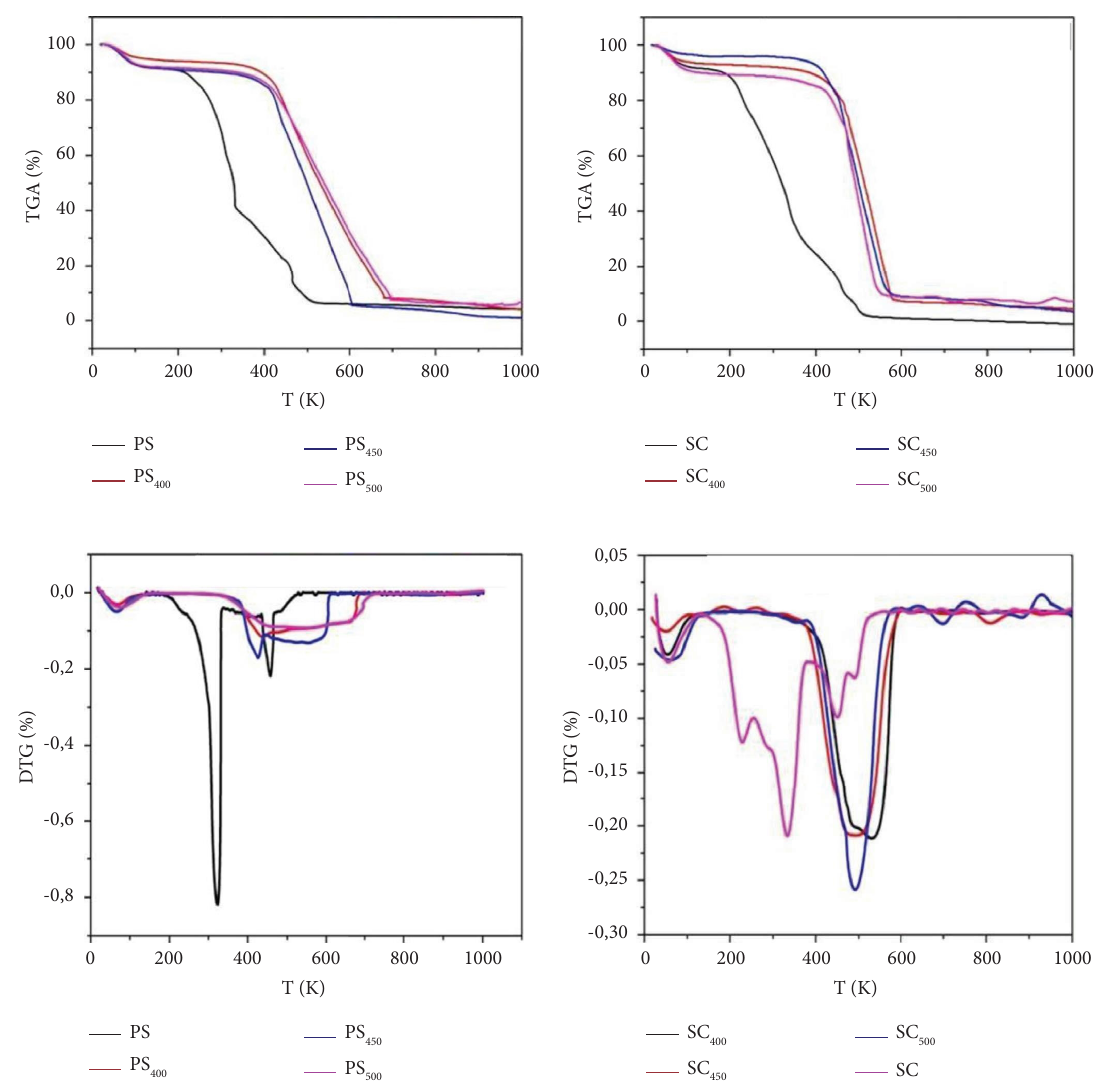
Figure 2: ATG/DTG curves of PS, PS 400 , PS 450 , PS 500 and SC, SC 400 , SC 450 , SC 500